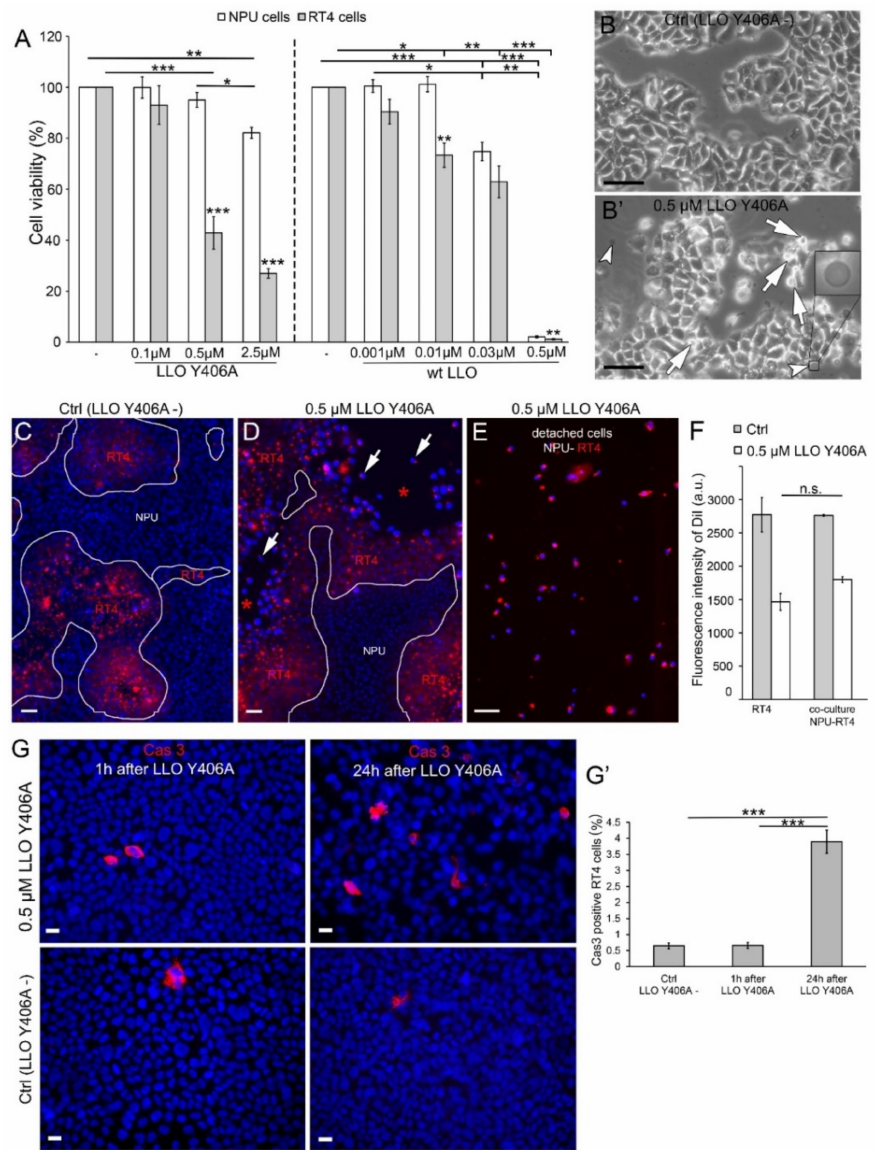
Figure 1. Cell viability and morphology of urothelial cells upon listeriolysin O (LLO) incubation. NPU and RT4 cells were treated for 2 h with LLO Y406A or wt LLO and viabilities measured 1 h post-treatment. ( A ) Cell viability of NPU and RT4 cells in control ( − ), 0.1, 0.5, and 2.5 µ M LLO Y406A, and in 0.001, 0.01, 0.03, and 0.5 µ M wt LLO. The data are presented as mean ± SEM, * p < 0.05, ** p < 0.005, *** p < 0.001. ( B ) Morphology of RT4 cells in medium without LLO Y406A and after 0.5 µ M LLO Y406A treatment ( B’ ). Morphology of RT4 cells changes from polygonal to spherical (arrows). LLO Y406A-treated RT4 cells release vesicles (arrowheads). Cells were imaged with a phase- contrast microscope. The vesicle in the right bottom corner is × 5 enlarged. ( C ) Co-cultures of NPU and RT4 cells, labeled with red lipophilic dye DiI, in control medium. ( D ) Co-cultures after 0.5 µ M LLO Y406A treatment have free surfaces (asterisks) with individual RT4 cells (arrows). ( E ) After LLO Y406A treatment, detached cells were collected and imaged. The representative image shows that the majority of cells are RT4 cells. ( F ) Quantification of DiI fluorescence in RT4 monocultures and RT4-NPU co-cultures reveals similar values ( p > 0.05). ( G ) Immunofluorescence of Cas3 (red) in control untreated RT4 cell and 1 h and 24 h after 0.5 µ M LLO Y406A treatment. Nuclei are stained with DAPI (blue). ( G’ ) Quantification of the number of apoptotic Cas3-positive RT4 cells, per all RT4 cells in a field of view (fields of view = 10, from three independent experiments). Scale bars: ( B – E ) are 50 µ m and ( G ) are 20 µ